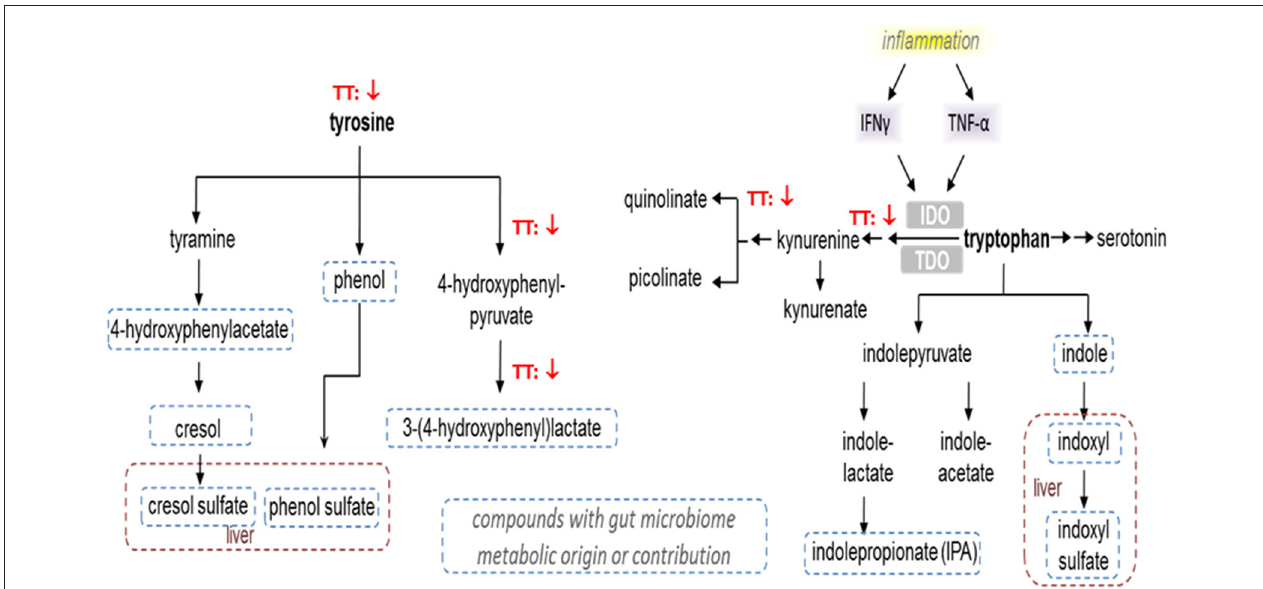
FIGURE 4 | Effect of tocotrienols supplementation on tyrosine and tryptophan metabolism. Proposed actions of tocotrienols on tyrosine and tryptophan metabolites based on serum analysis from subjects. Tocotrienols tended to result in lower levels of compounds where the downward arrows are